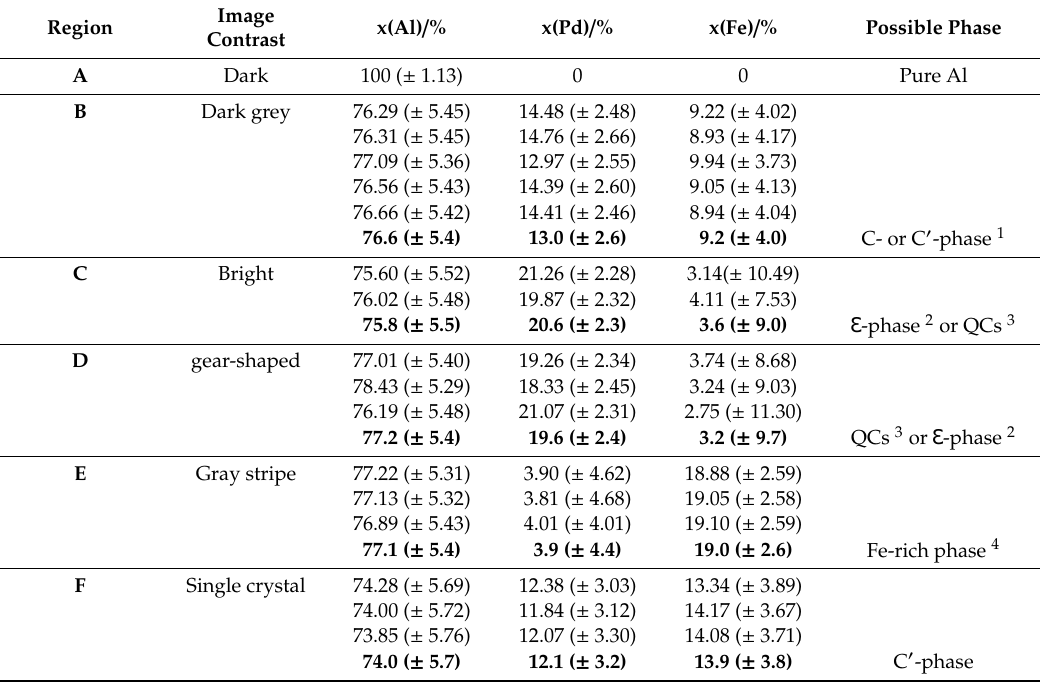
Table 1. The chemical compositions of a piece of educts and a fragment of single crystal from the spark plasma sintering samples analyzed by the EDS (bold numbers indicate the mean values of di ff erent measured chemical compositions in the same region). Regions A–F are denoted in Figure